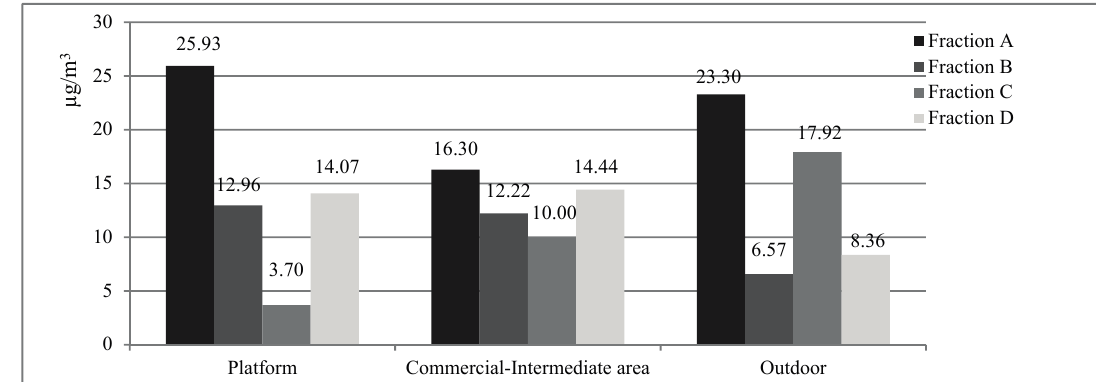
Figure 1. Concentrations (µg/m 3 ) of coarse (fraction A: 2.5–10 µm) and fine (fraction B: 1–2.5 µm; fraction C: 0.5–1 µm; fraction D: 0.25–0.5 µm) airborne particulate matter at the three sampling